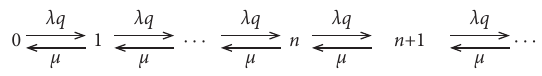
Figure 1: The transition rate diagram of unobservable